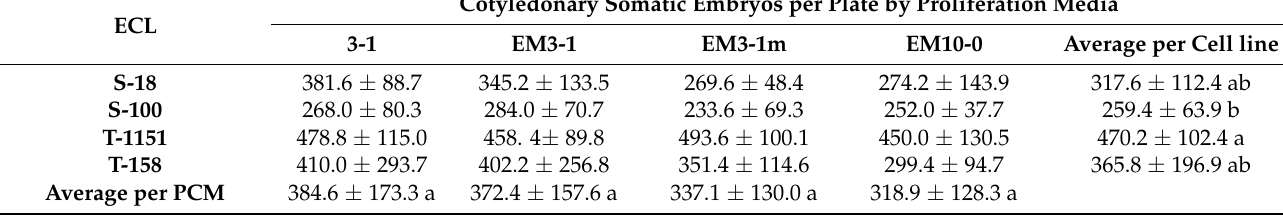
Table 11. Effect of proliferation culture media (PCM) on somatic embryo maturation efficiency of sugi embryogenic cell lines (ECLs). Data are presented as the mean ± SD (standard deviation) of the number of cotyledonary somatic embryos per plate from five replicates for each ECL matured after culturing on different PCM.